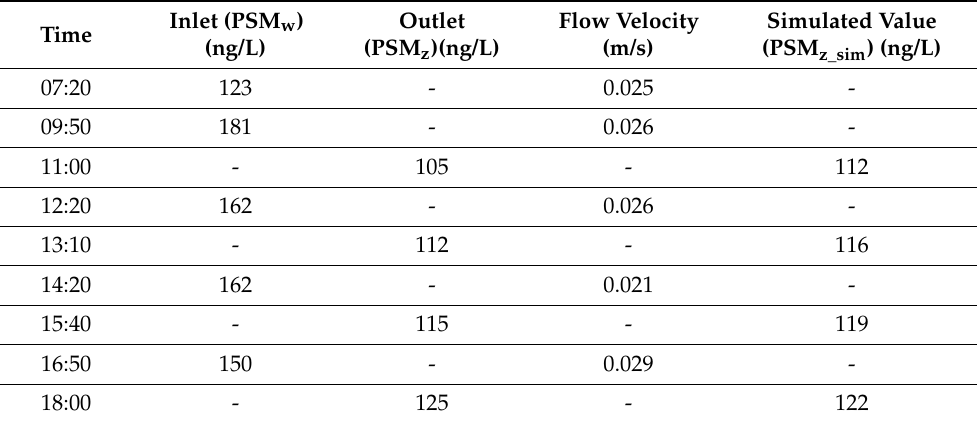
Figure 13. Case study location, investigated channel reach, and monitored points. Table 3. Carbamazepine concentrations at the inlet (PSMw) and outlet (PSMz) points of the vegetated channel on 28 May 2018, and simulated results.